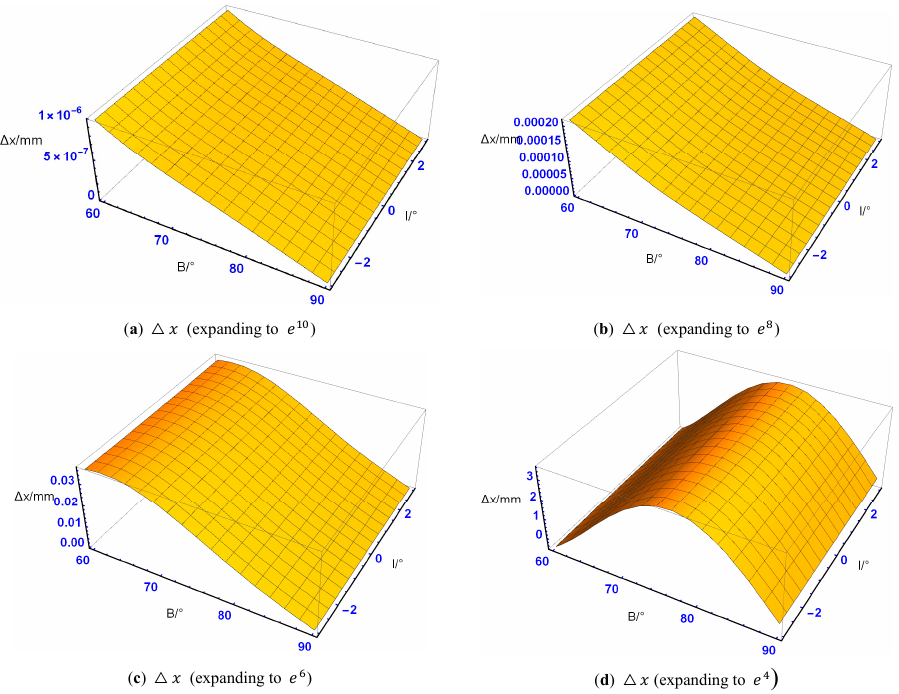
Figure 4. The distribution of the abscissa truncation difference ∆ x when expanding to e 10 , e 8 , e 6 , and e 4 .